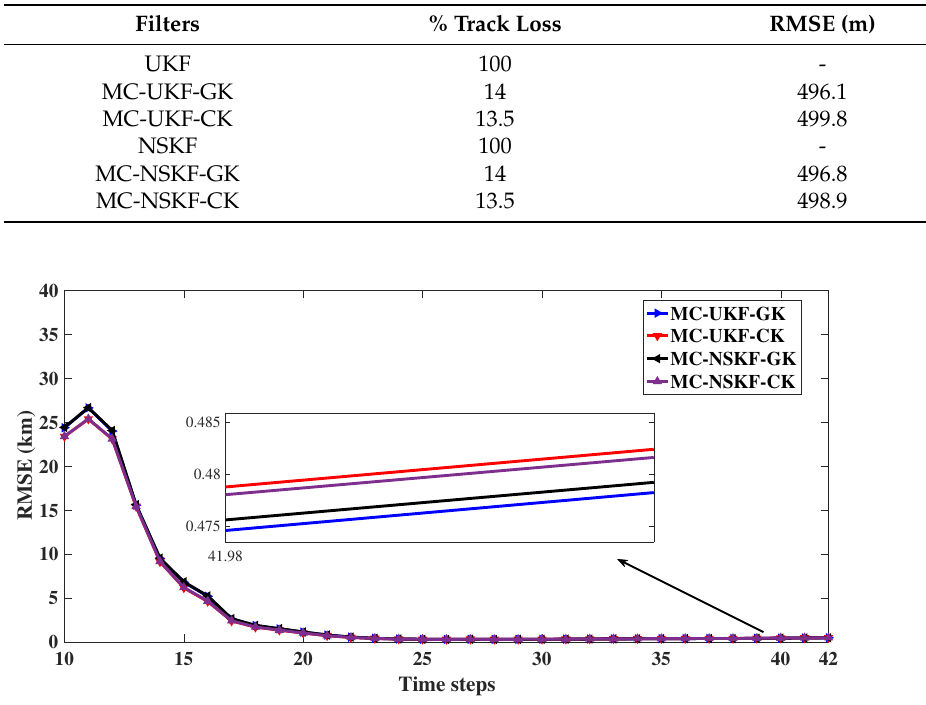
Figure 10. 3D: RMSE in